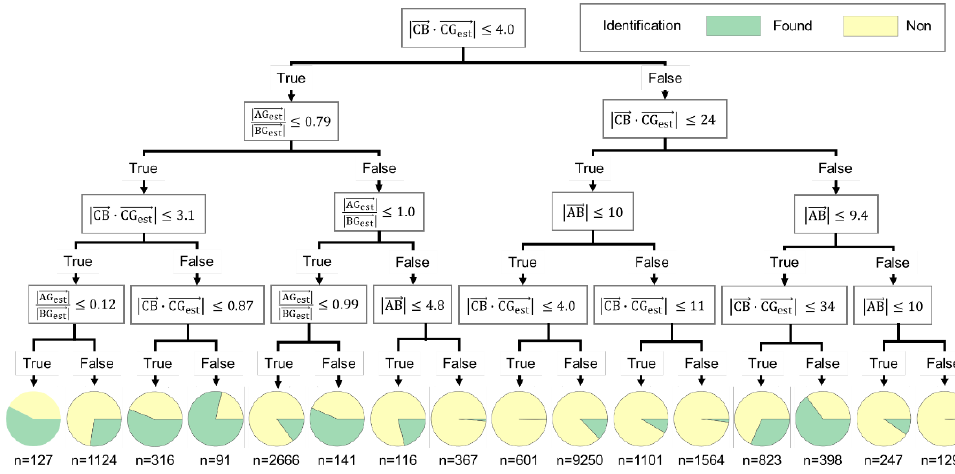
Figure 3. Typical decision trees in this prediction